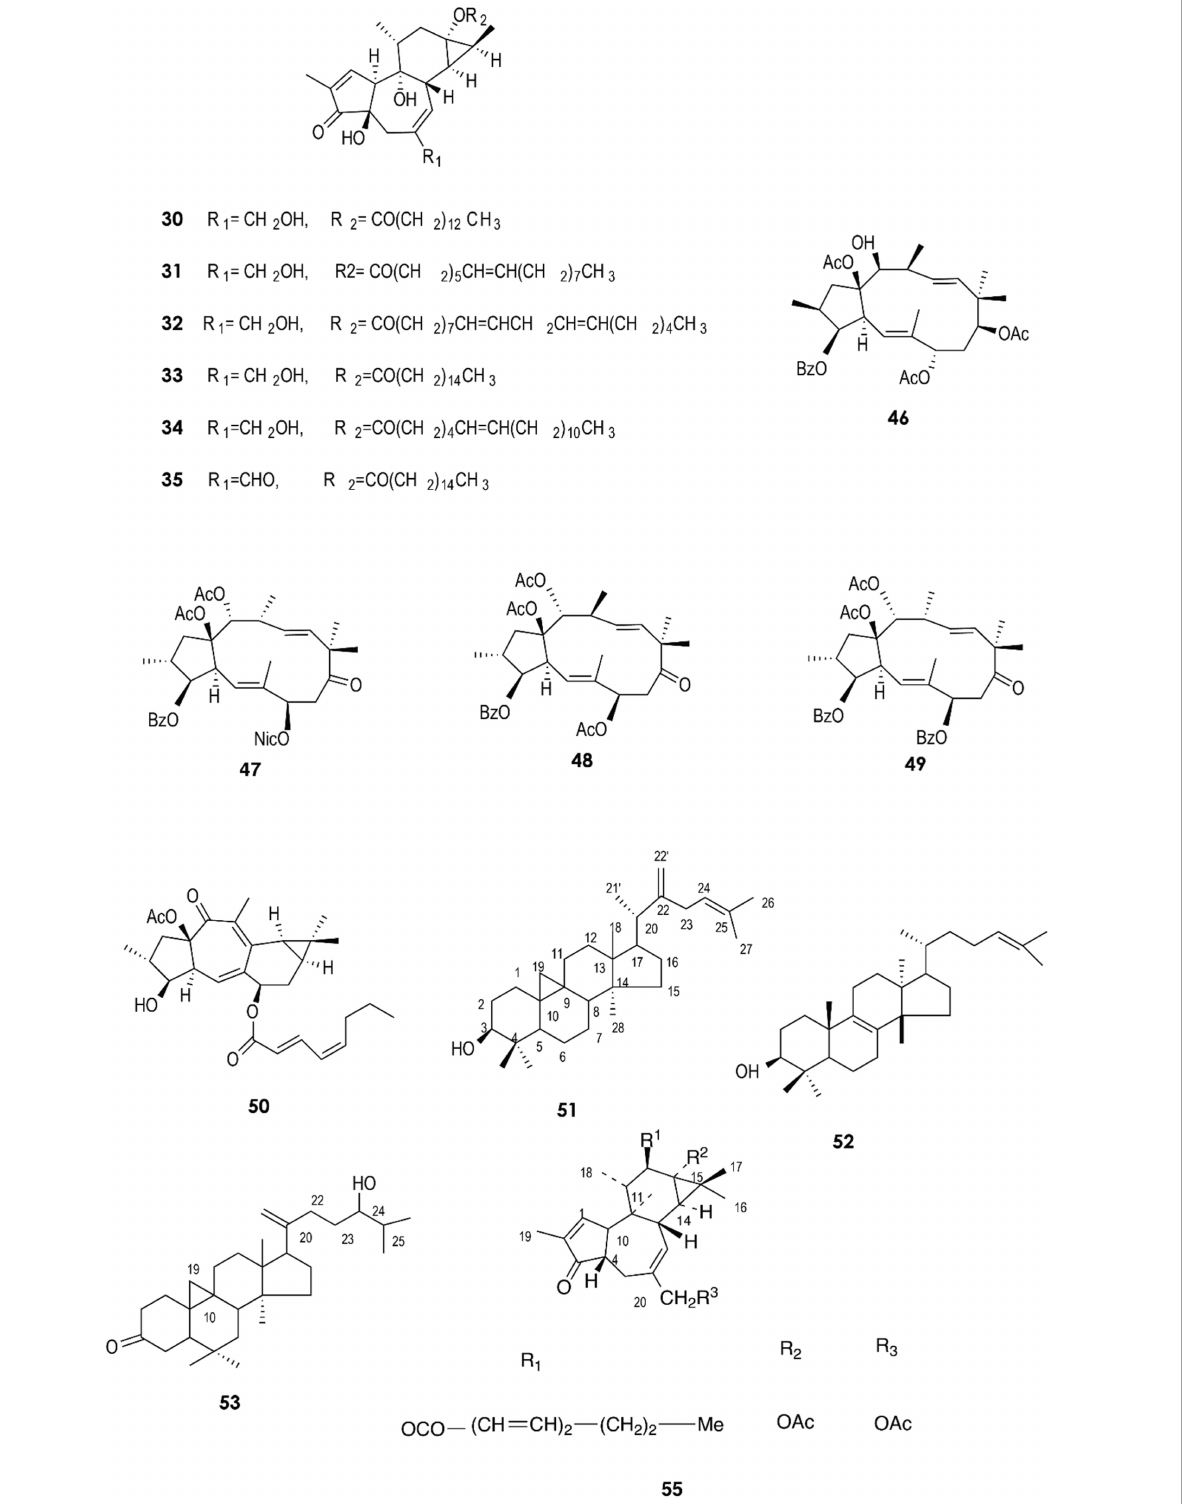
FIGURE2 Structure of chemicals compounds (30-35, 46-53) and (55) (Urones et al., 1988; Ilyas et al., 1998; Mallavadhani et al., 2004; Hua et al., 2015; Deng et al., 2021).